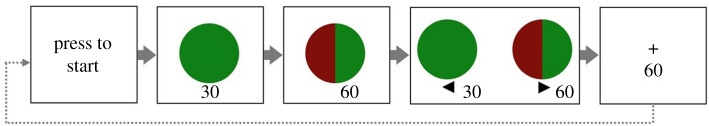
The trial procedure of Experiment 1B, which is similar to the original task by Verbruggen et al. [17].